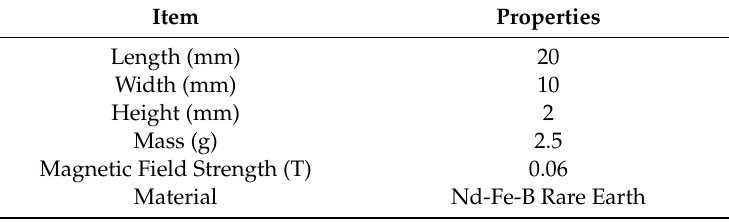
Table 3. Dimensional and magnetic properties of the bias magnetic.